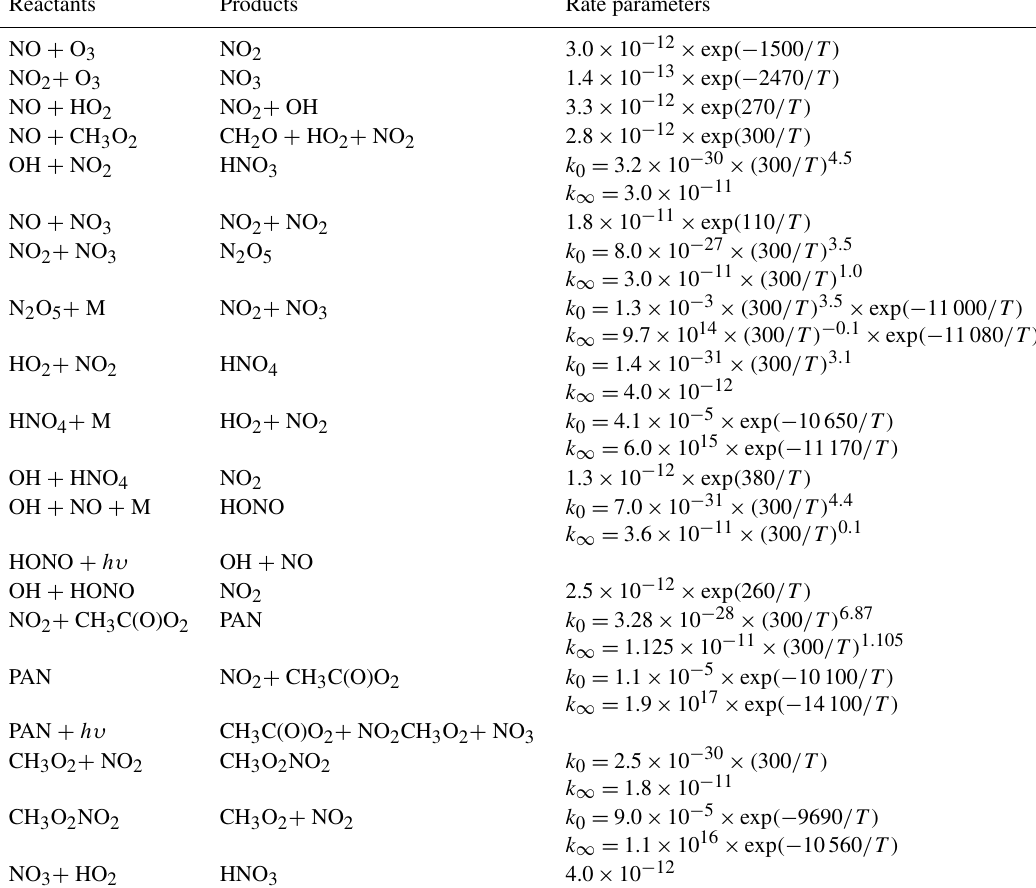
Table 1. Details of the reaction rate data applied for NO x and nitrogen reservoirs. The k 0 terms are multiplied by the relevant air density to calculate the correct forward and backward rate constants. The reaction data and stoichiometery are taken from Atkinson et al. (2004) accommodating the latest evaluation at